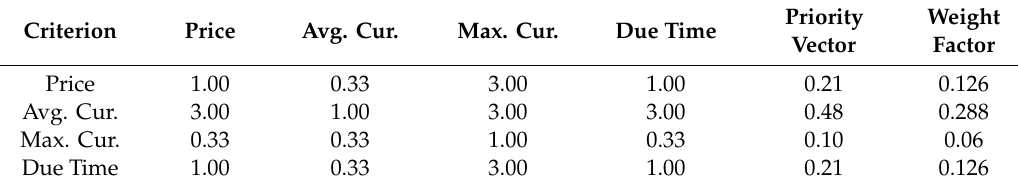
Table 7. The analytic hierarchy process (AHP) criteria as defined by the driver. Criterion